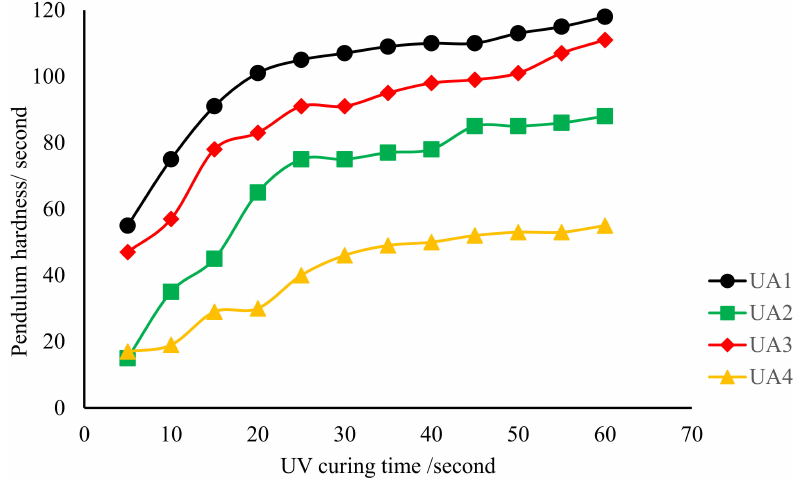
Figure 8. Pendulum hardness of the UA-cured film at various UV curing